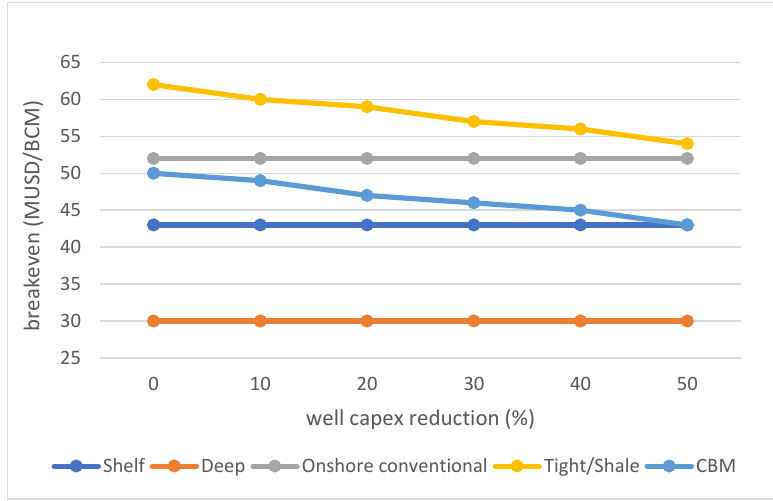
Figure 8. Mid-plateau breakeven price as a function of well capex reduction.